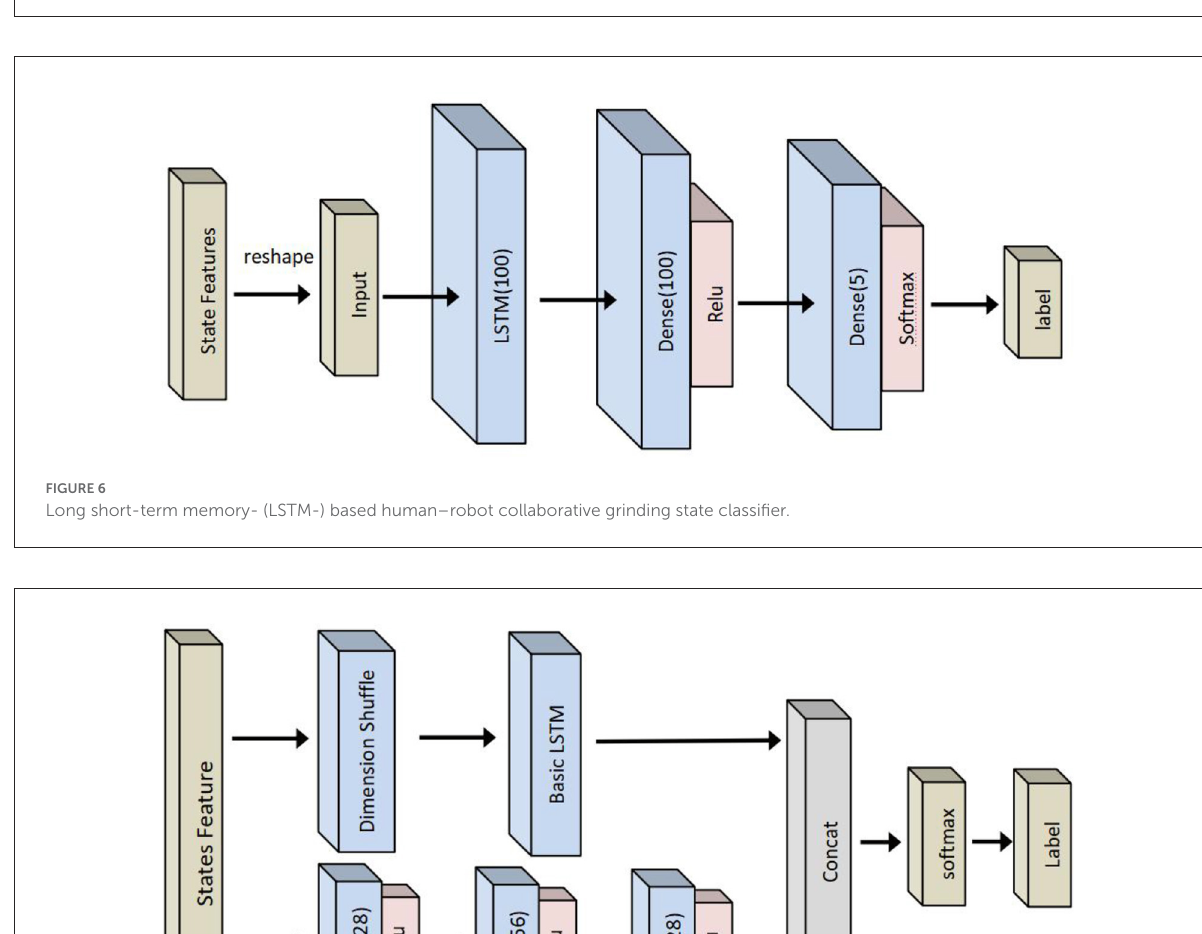
reaction speed. The selected features are then put into an LSTM- based classifier to train the classifier model. Model parameters are later used to construct an online classifier of the PHRC grinding